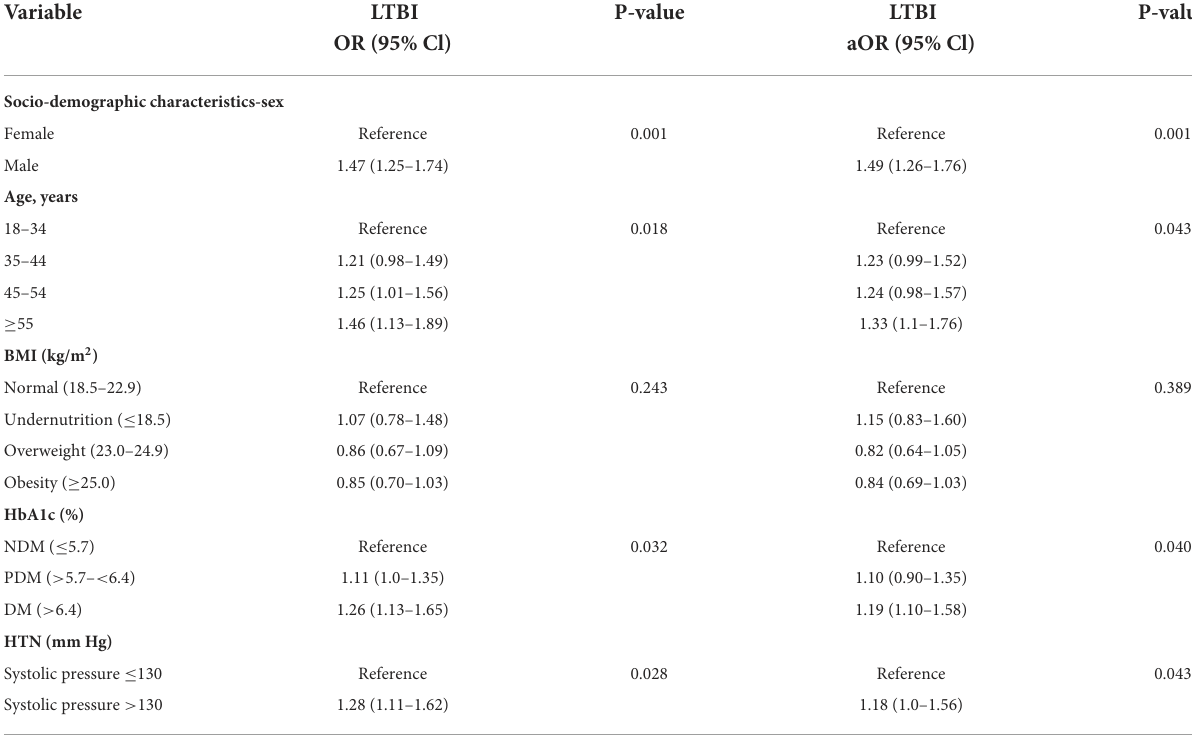
TABLE 2 Association of clinical co-morbidities with latent tuberculosis-infected South Indian adult population enrolled between 2013 and 2020.